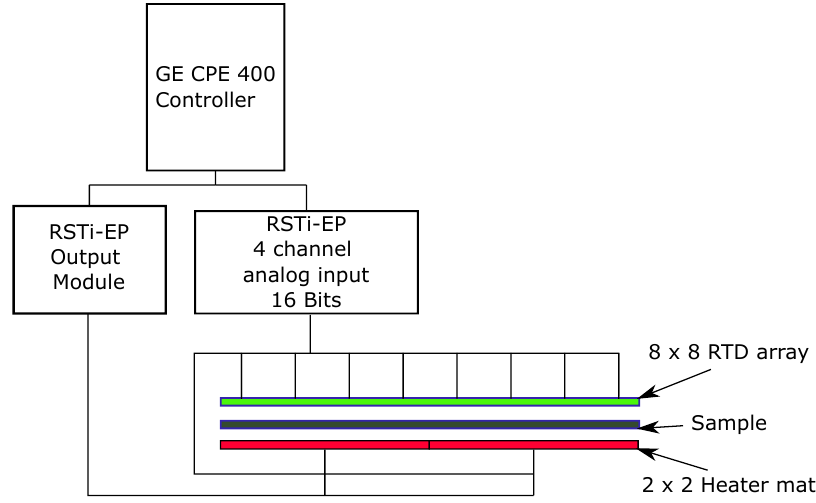
Figure 6. Experimental set up of temperature controller and data